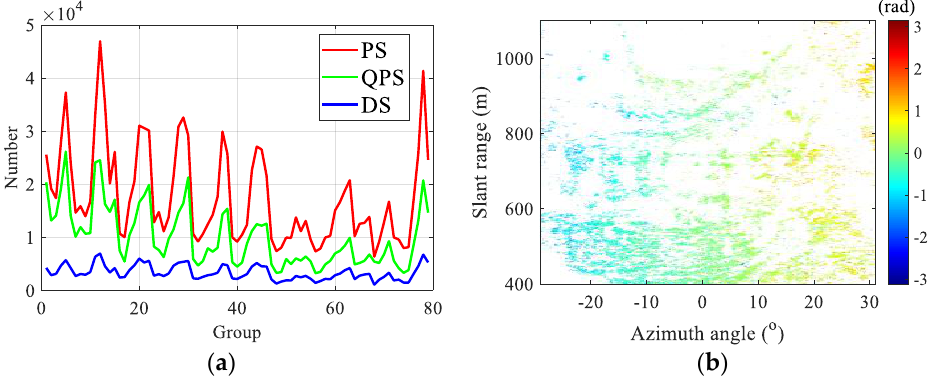
Figure 15. ( a ) Cumulative deformation map of the first 30 images; ( b ) probability density curves of the deformation std of three types of pixels: PS, QPS, and DS.